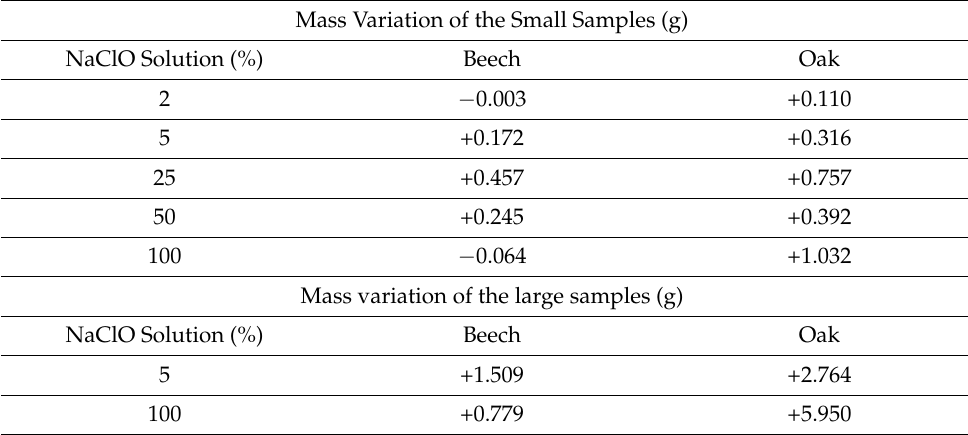
Table 5. Mass of the samples after three months of